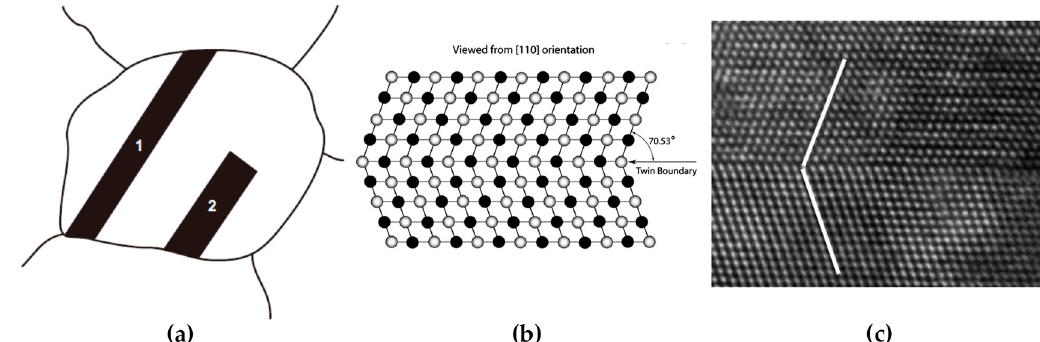
Figure 9. ( a ) A schematic diagram of coherent and incoherent twin boundaries; ( b ) A mirror symmetry of atoms in a coherent twin boundary in fcc metals viewed from the [110] direction; ( c ) A typical HREM image of a twin in a fcc metal. (Reprinted from References [27,58], with permission from Elsevier).